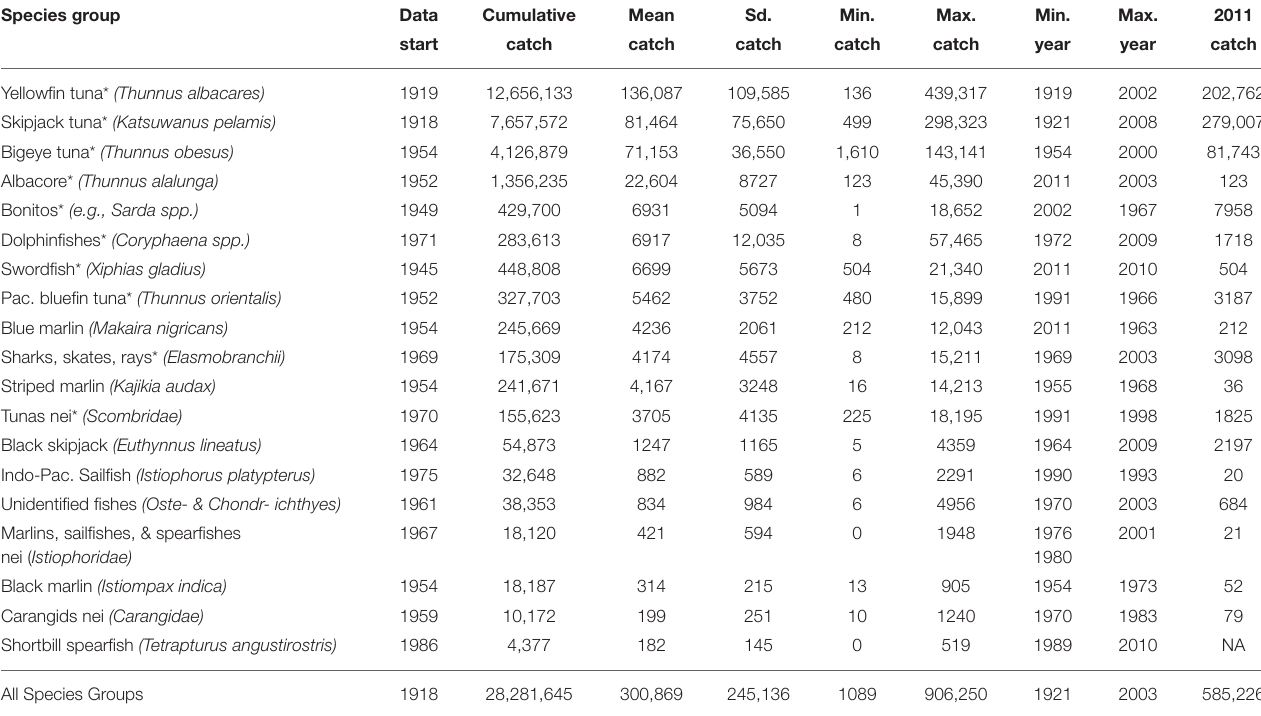
TABLE 1 | Summary of commercial fisheries catches in the eastern tropical Pacific (ETP). Species group Data Cumulative Mean